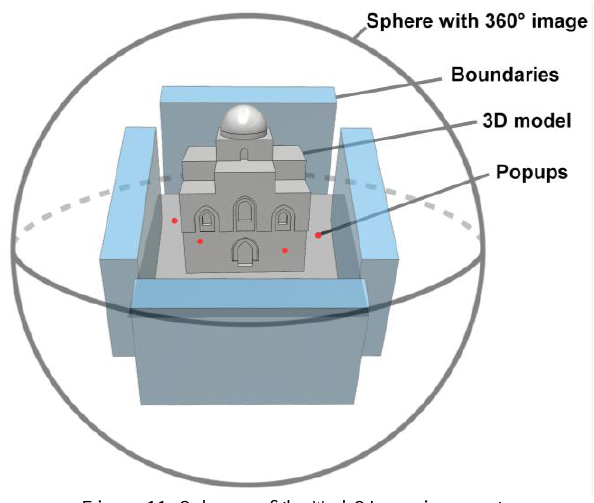
Figure 11. Scheme of the WebGL environment.